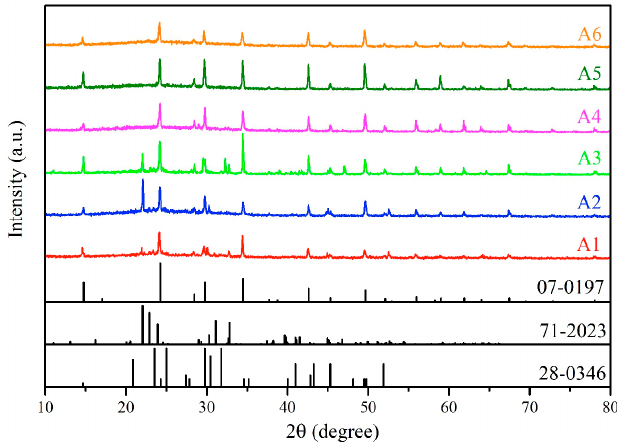
Figure5. TheXRDpatternsofCs 2 SnCl 6 crystalspreparedwithnewlysynthesizedSnCl 2 atdi ff Figure 5. The XRD patterns of Cs 2 SnCl 6 crystals prepared with newly synthesized SnCl 2 at different time.